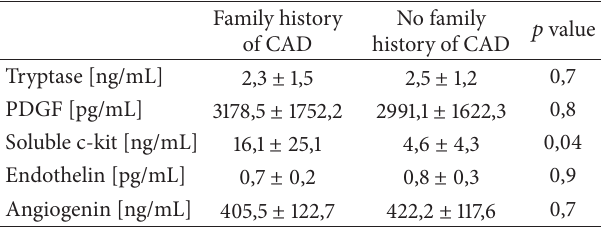
Table 8: The differences in tryptase, PDGF, soluble c-kit, ET-1, and angiogenin levels between STEMI patients with or without significant LAD stenosis. The analysis was made using 𝑡